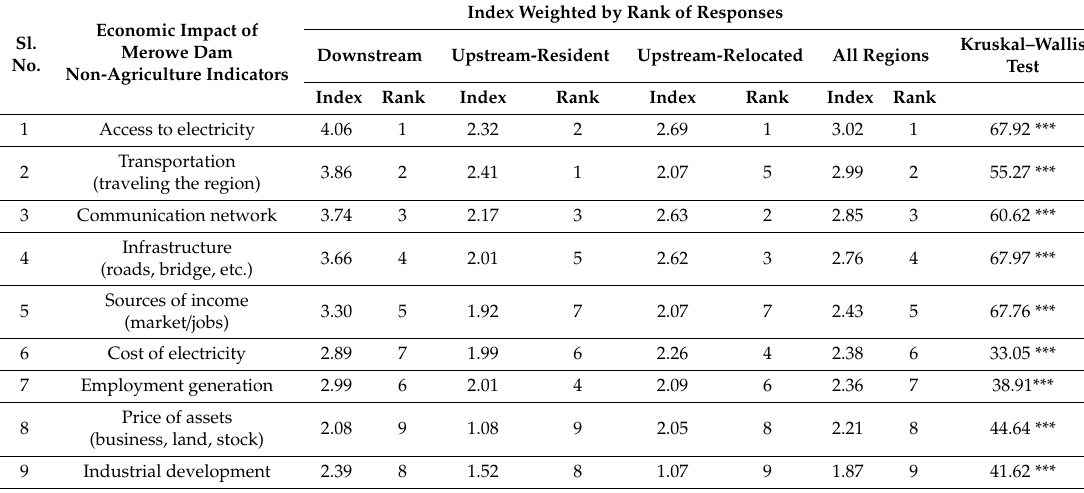
Table 7. Ranking non-agricultural indicators by